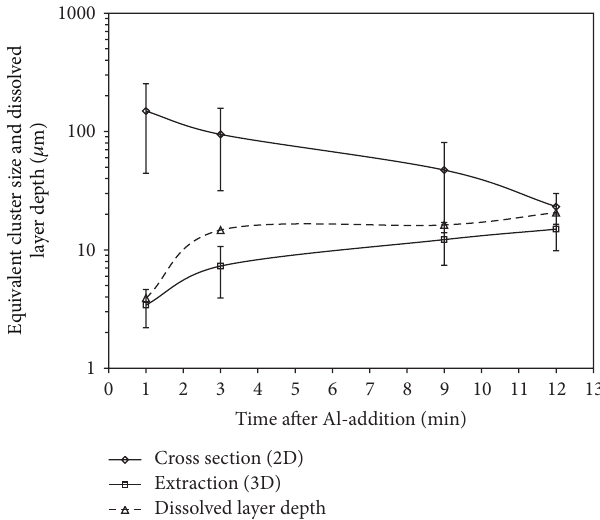
Figure 6: Equivalent cluster size obtained from the CS (2D) and EE (3D) methods and dissolved layer depth as a function of holding